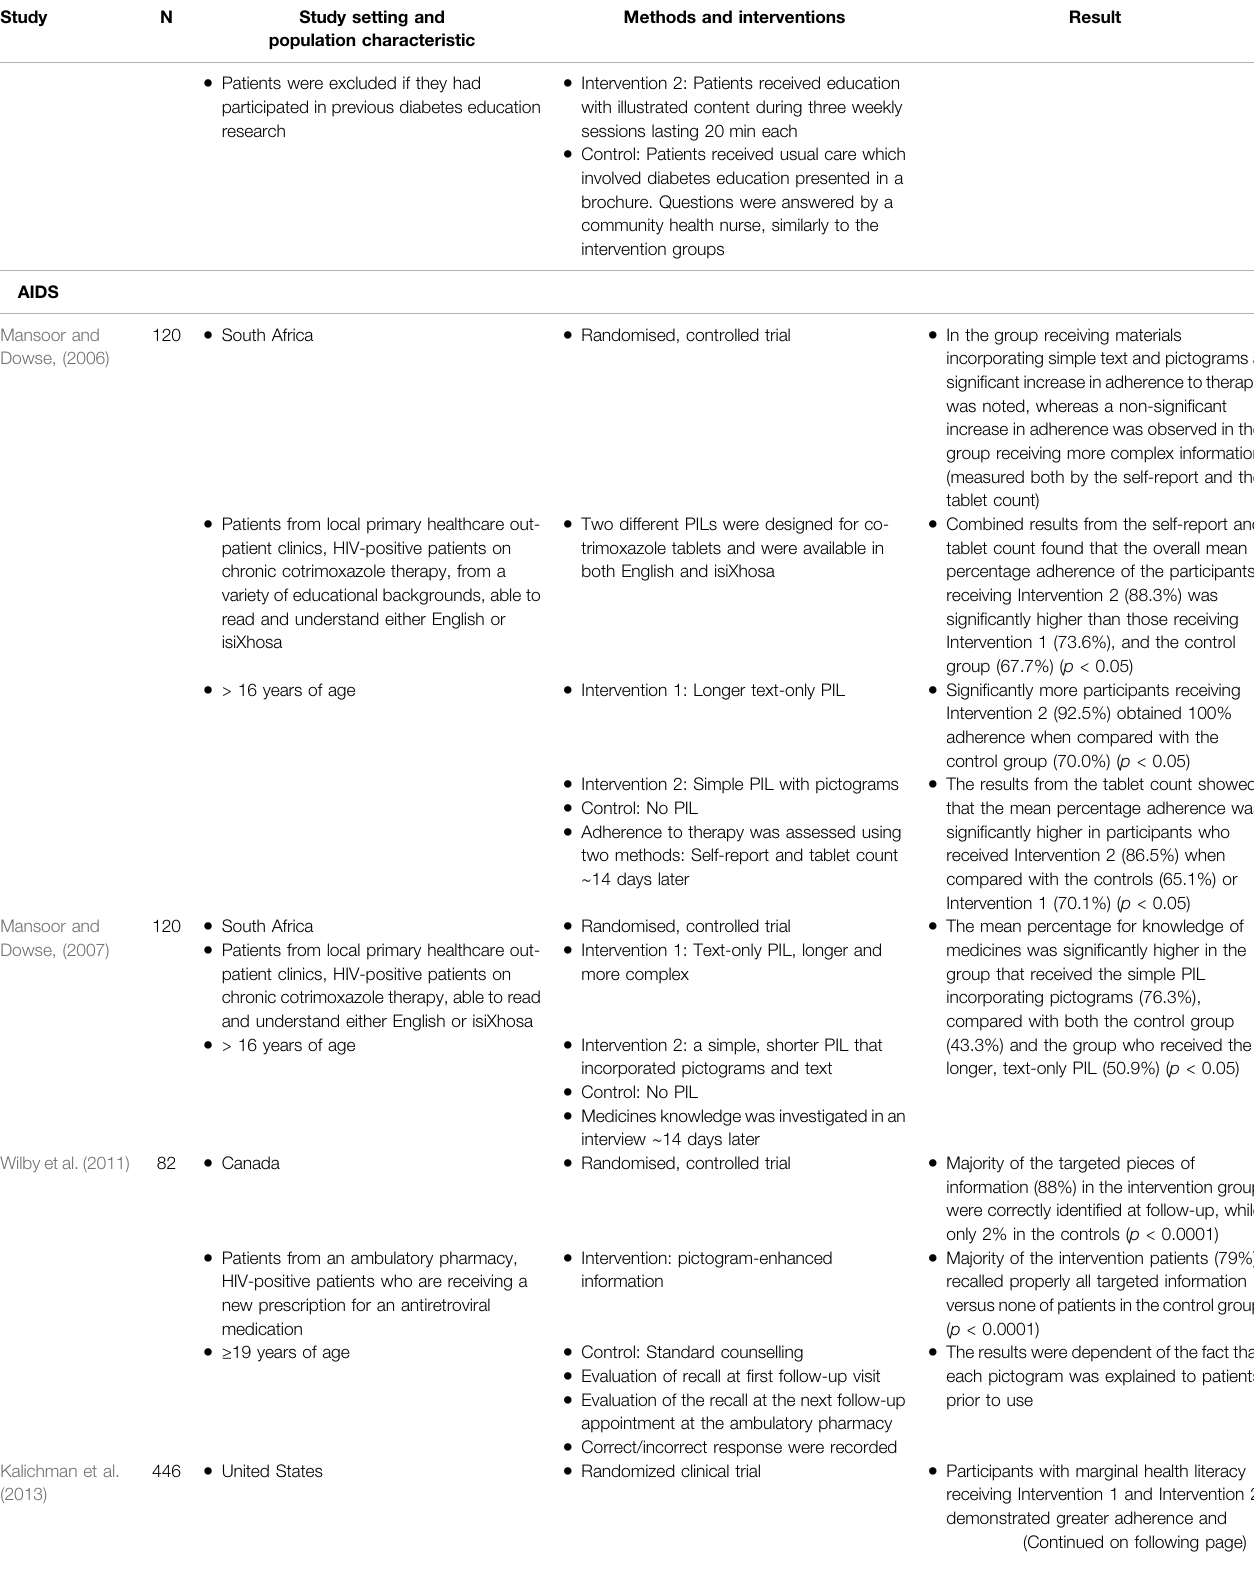
TABLE 1 | ( Continued ) Pictograms in the pharmaceutical care of chronically ill